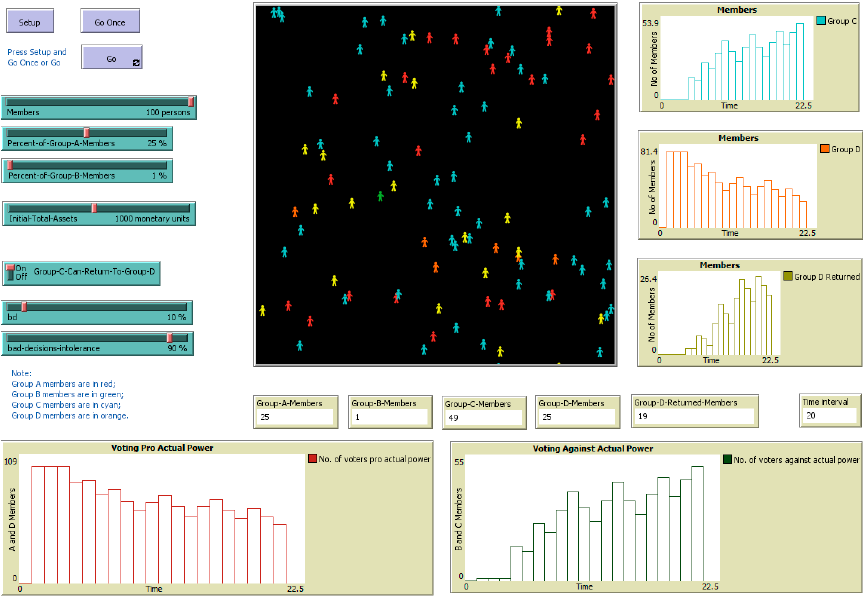
Figure 4. A snapshot of the NetLogo 6.0.4. model’s interface at t = 20 ticks.